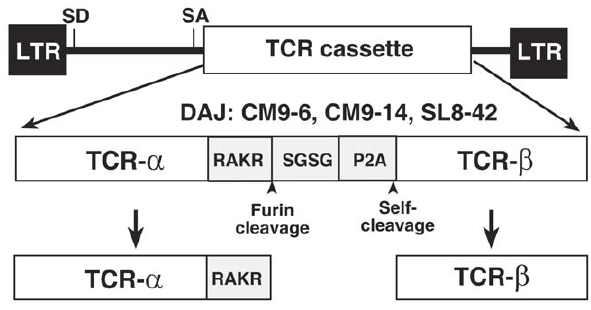
Figure 1. Diagram of TCR expressing retroviral vector and the mature TCR chains. The MSGV1 murine retroviral vectors sequences are displayed as black boxes and lines while the TCR expression cassette is in white. The fine structure of the TCR chain fusion cassette is presented below the vector with the different MamuA*01-restricted TCRs molecularly-cloned from DAJ T-cell clones that were inserted into the vectors indicated above the cassette. The sequences separating the TCR genes, the furin recognition sequence, KAKR, the S-G-S-G spacer, and the P2A fowl pox self-cleaving peptide, are shaded gray. The furin cleavage site and the P2A self-cleavage site are indicated below the cassette with arrows. The mature a and b chains produced by this vector are displayed at the bottom of the